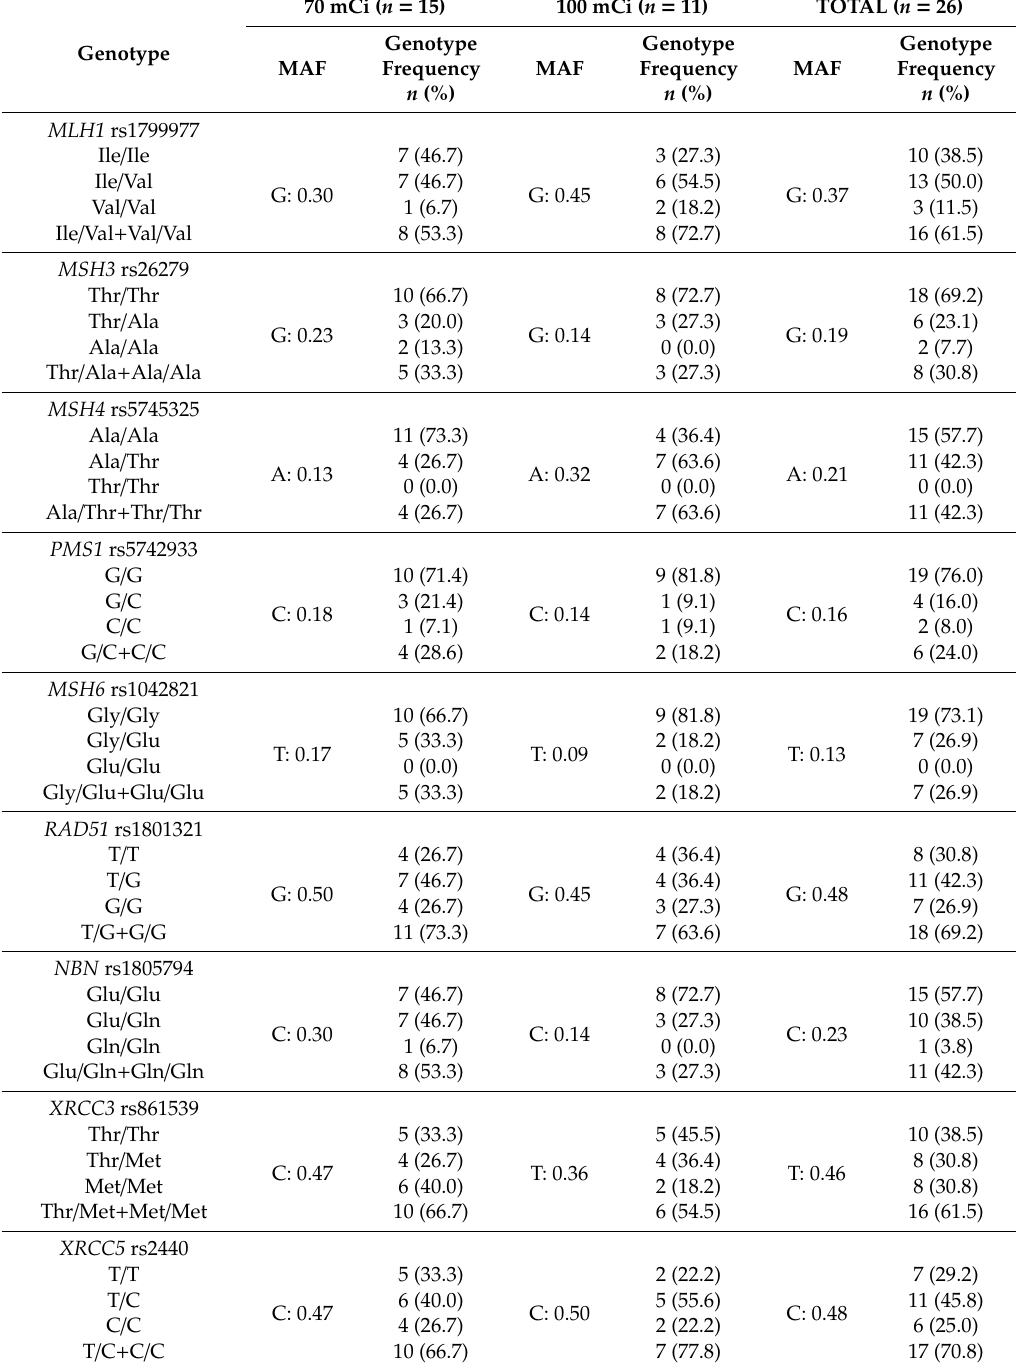
Table 3. Allele and genotype frequencies in DTC patients submitted to 131 I